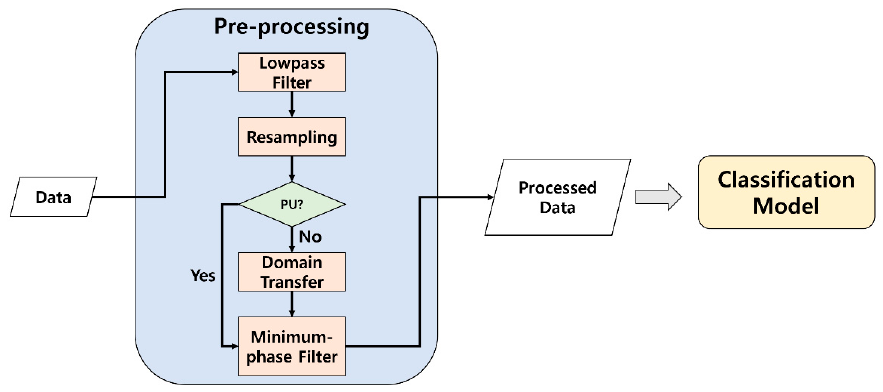
Figure 1. Flowchart of proposed method.